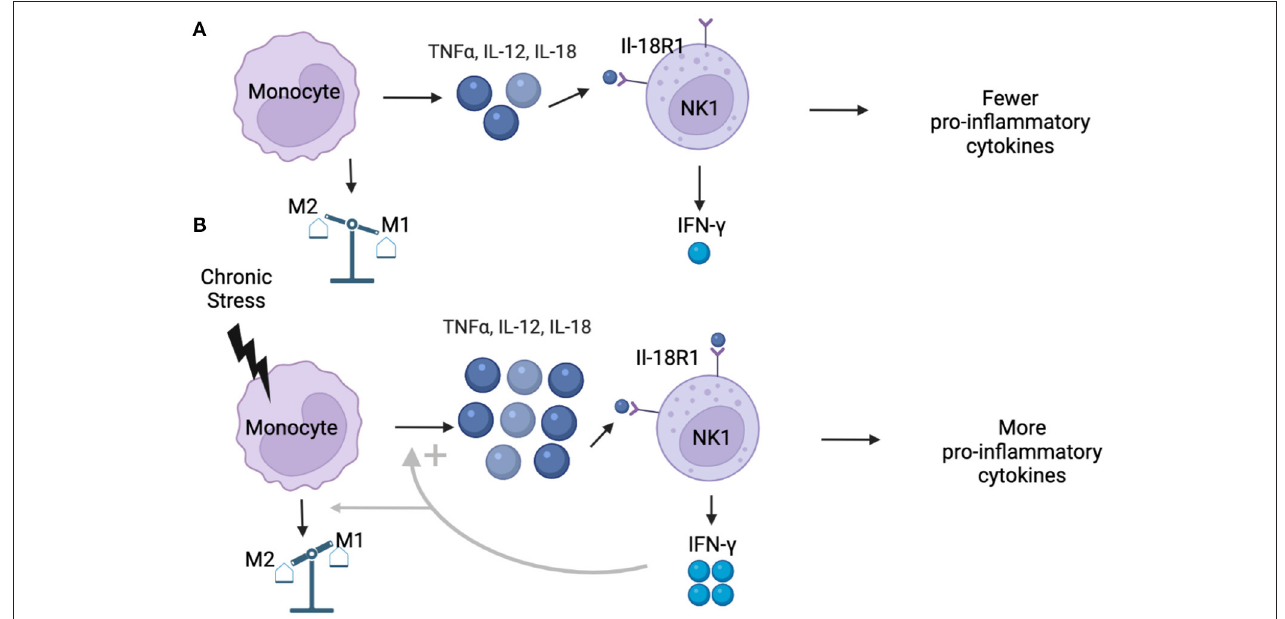
FIGURE 1 | (A) Under normal conditions, monocytes produce low concentrations of pro-inflammatory cytokines including TNF α , IL-12, and IL-18. Simultaneously, pregnancy is characterized by shift that reduces the proportion of NK1 (IL-18R1) cells in circulation. Existing NK1 cells are weakly stimulated by low concentrations of IL-18, resulting in low production of IFN- γ , ultimately resulting in more M2 decidual macrophages and a less pro-inflammatory environment that characterizes the second and third trimesters of healthy pregnancies. (B) Under conditions of chronic stress, monocytes are stimulated at higher rates, resulting in greater production of pro-inflammatory cytokines, including IL-18. Higher concentrations of IL-18 activate NK1 cells at higher rates than under healthy conditions, leading to increased production of IFN- γ , which can promote an M1 over M2 bias in the decidua. When monocytes in pregnant individuals are stimulated in the presence of IFN- γ , the pro-inflammatory response is exaggerated, leading to even higher concentrations of pro-inflammatory cytokines, which could result in a pro-inflammatory bias in individuals experiencing chronic